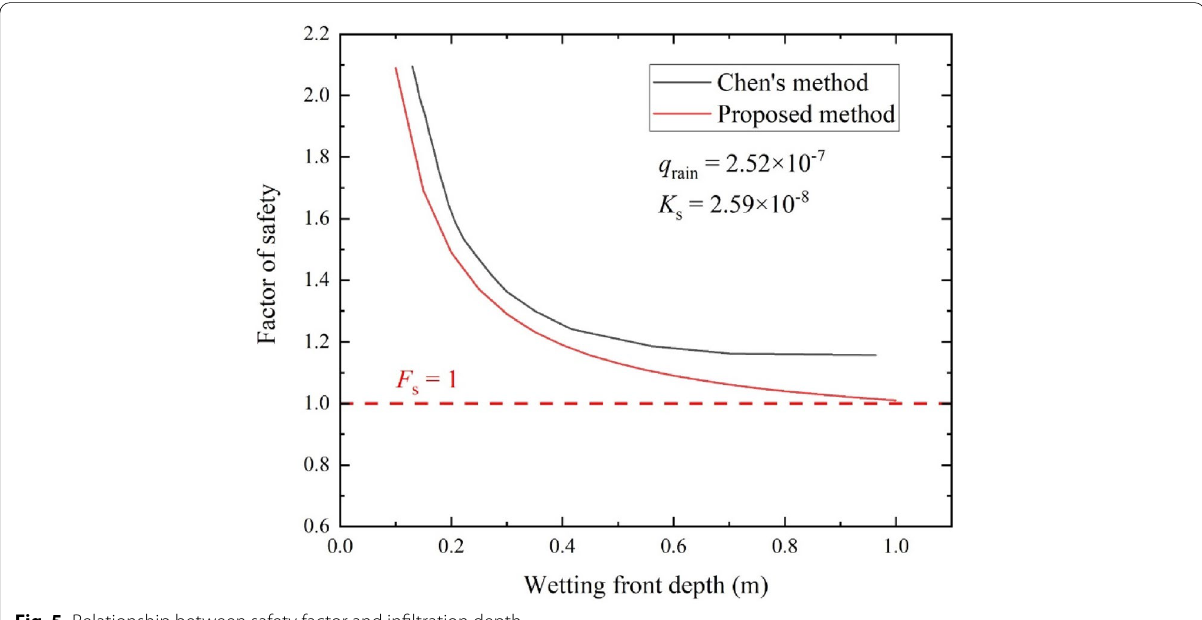
Fig. 5 Relationship between safety factor and infiltration depth